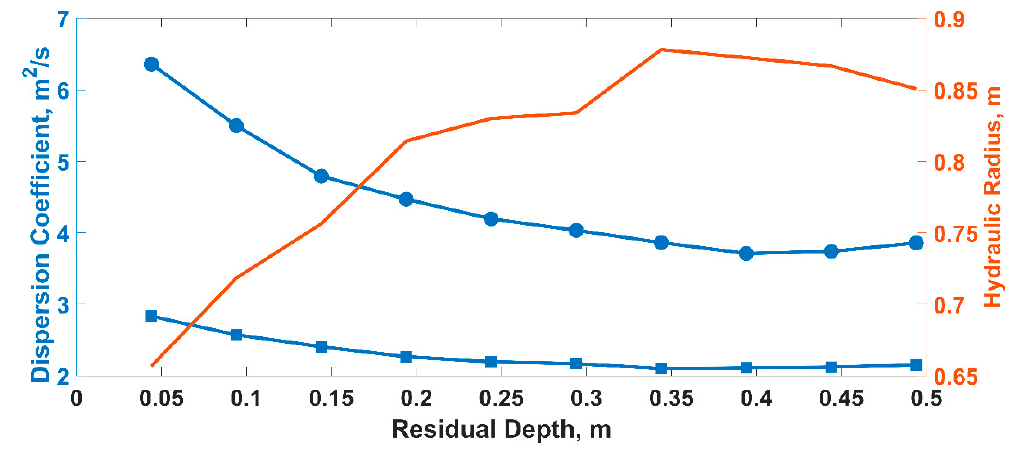
Figure 6. Comparison of the method of Thomann and Mueller [54] and the method of the moments [55] for estimation of the longitudinal dispersion coe ffi cient for the bathymetries described in Table 2. Variation of the dispersion coe ffi cient (blue) and the hydraulic radius in the pool (orange) with respect to the residual pool depth for ( a ) method of Thomann and Mueller (box); and ( b ) method of the moments (circles).